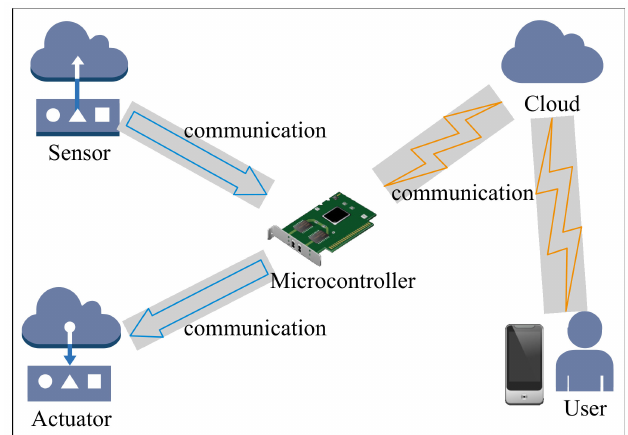
Figure 1. The overview of an IoT